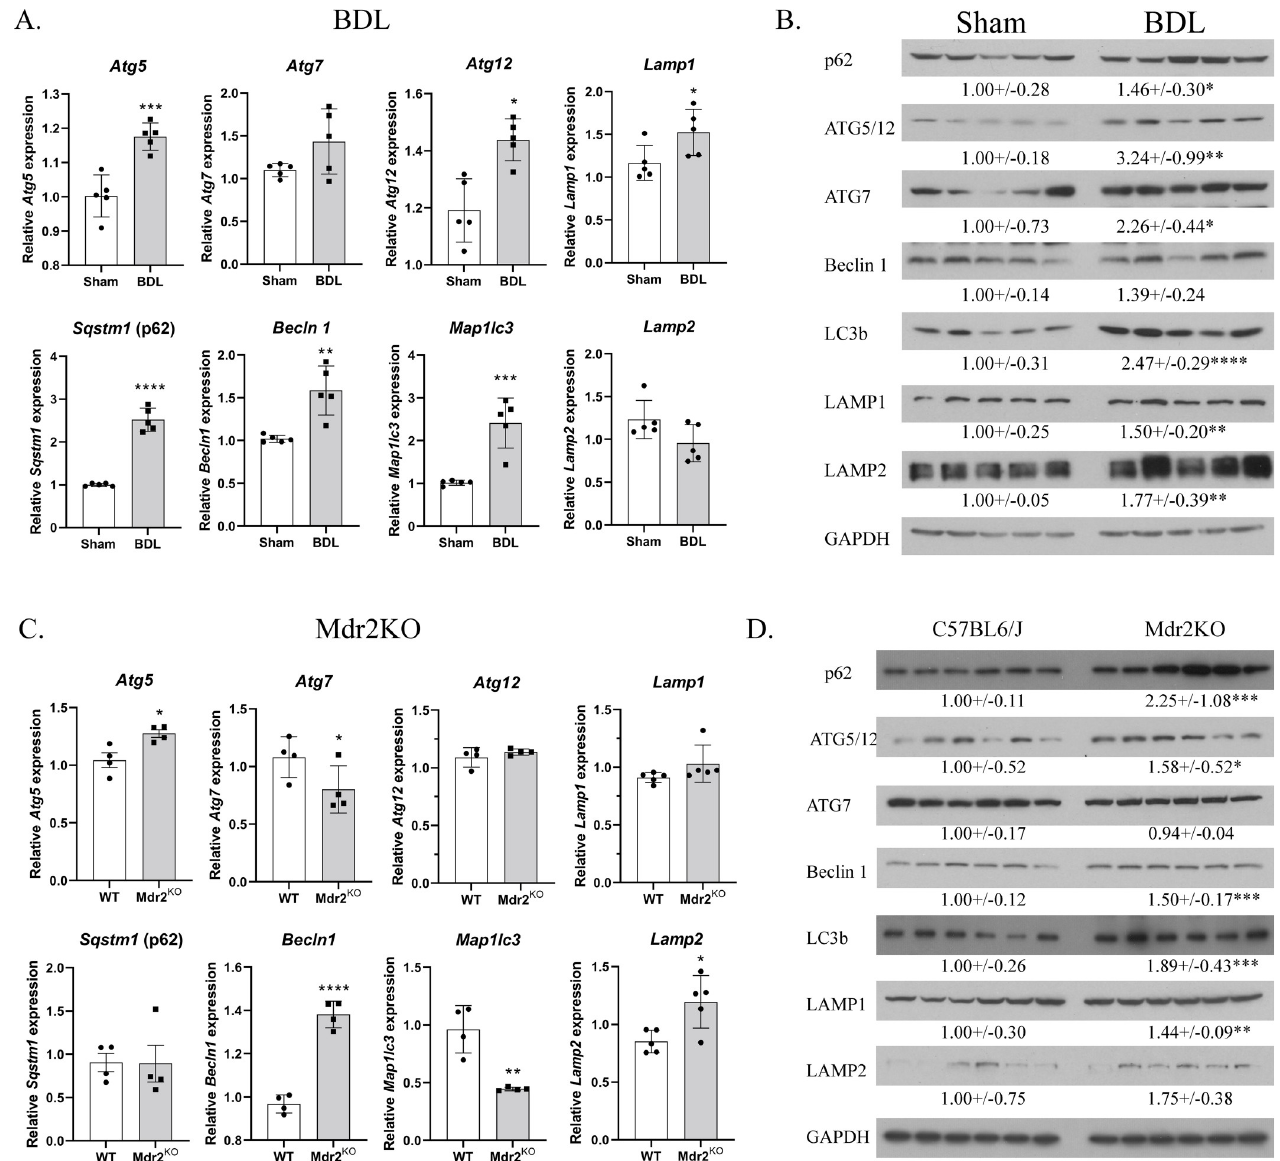
Fig 2. Increased expression of autophagic proteins in acute murine cholestasis. A . qPCR analysis of mRNA for autophagic proteins in liver tissue isolated from 3-day sham and BDL adult mice (N = 5/group). Expression was normalized against HPRT. B . Western analysis of autophagic proteins in liver tissue isolated from BDL mice (N = 5/group). Blots were normalized to GAPDH expression. C . qPCR analysis of mRNA for autophagic proteins in liver tissue isolated from 10-week old Mdr2 KO mice (N = 4/group). D . Western analysis of autophagic proteins in liver tissue isolated from 10 week on Mdr2 KO mice (N = 6/group). Blots were normalized to GAPDH expression Data are presented as Mean ± STDEV and were statistically analyzed using a Student’s t-test, � p < 0.05, �� p < 0.01, ��� P < 0.001, ���� p < 0.0001, N =